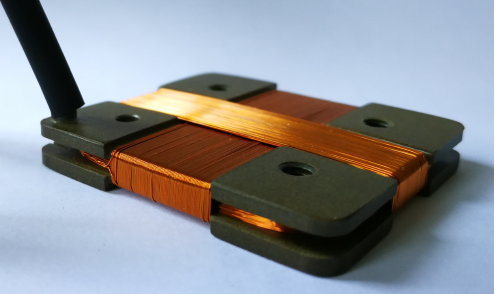
Figure 12. Prototype of a three axis pick-up magnetic probe for RFX-mod2 (37 × 42 × 5 mm).